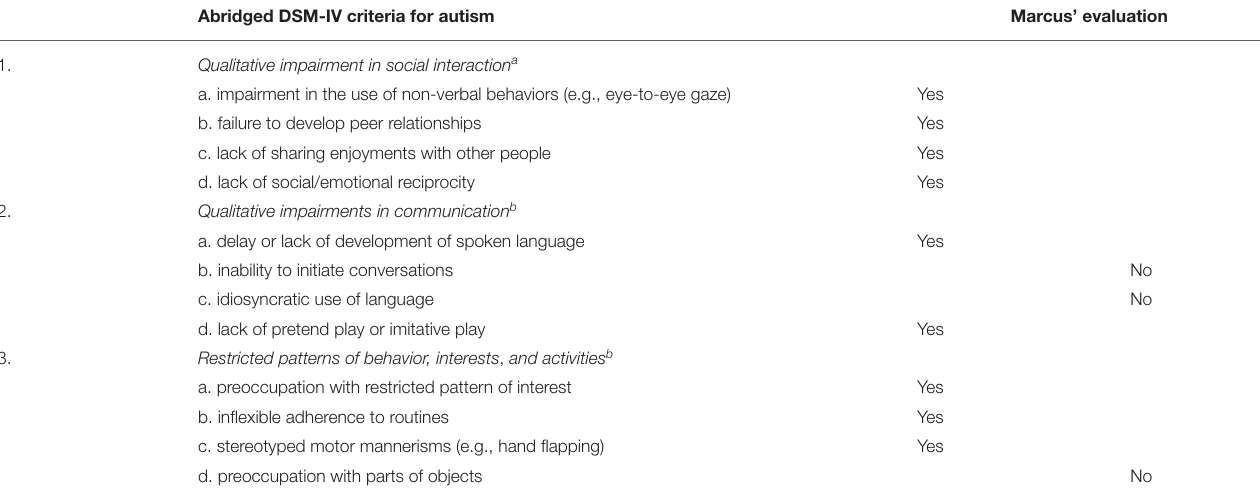
TABLE 2 | The criteria for an autism diagnosis according to DSM-IV-TR that Marcus fulfilled according to the clinical evaluation.